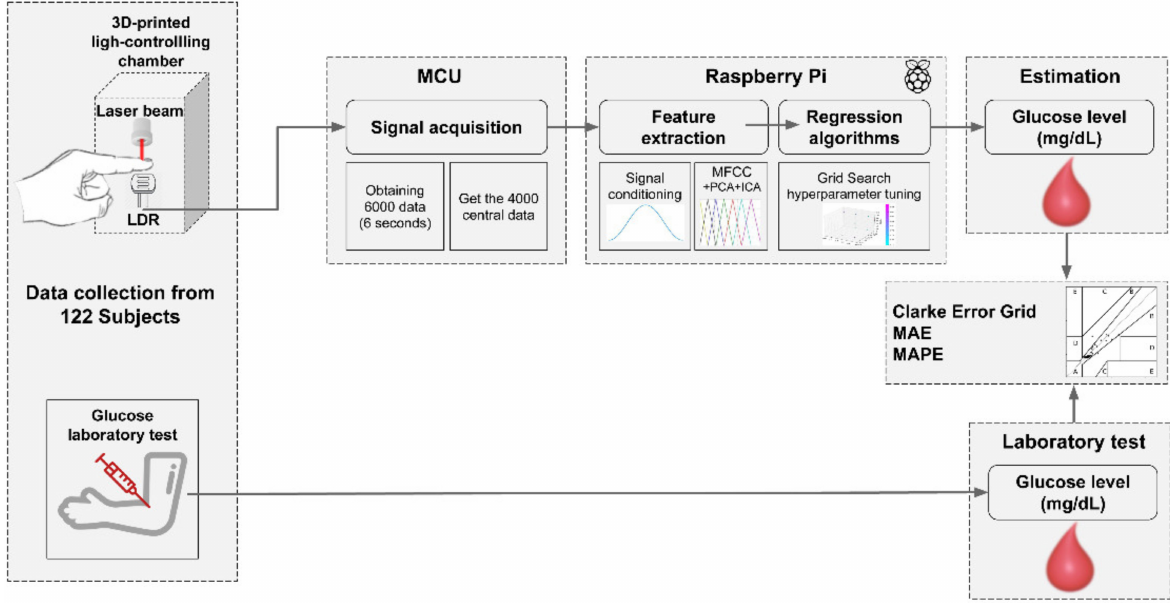
Figure 1. Overview of the proposed